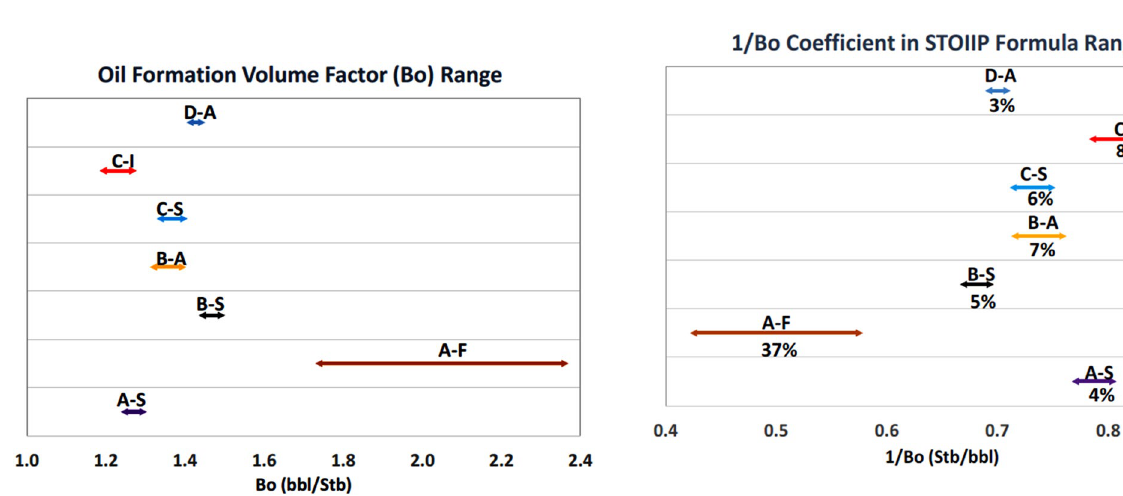
Fig. 3 Bo range of PVT samples of each reservoir